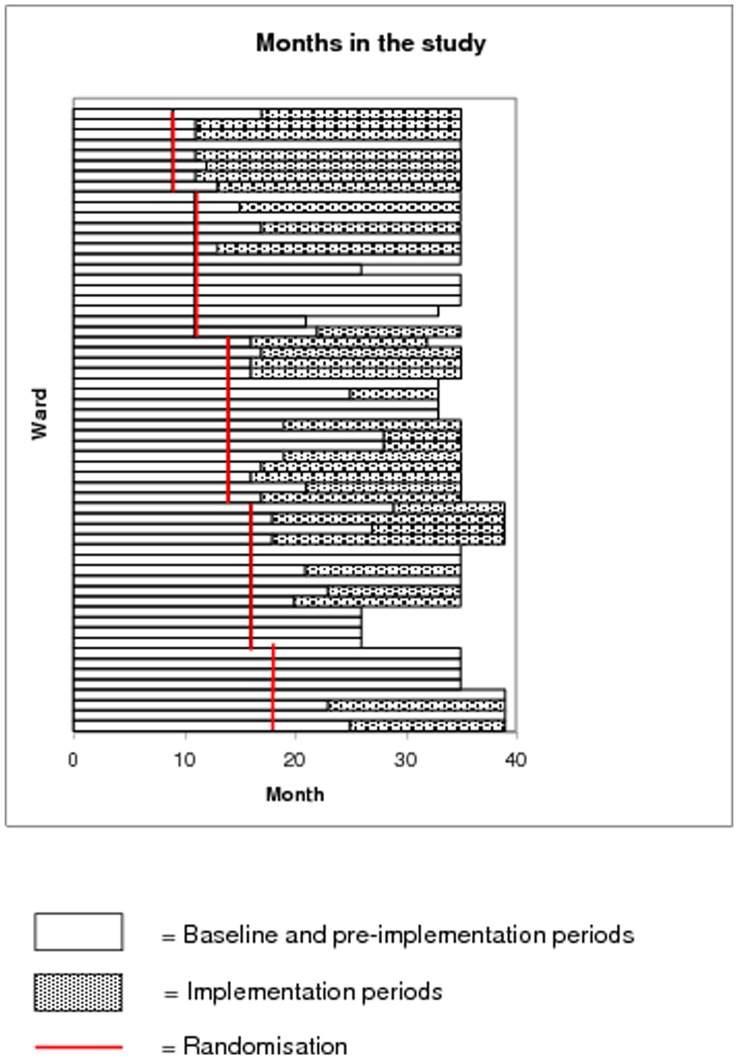
Timeline for randomisation and implementation.